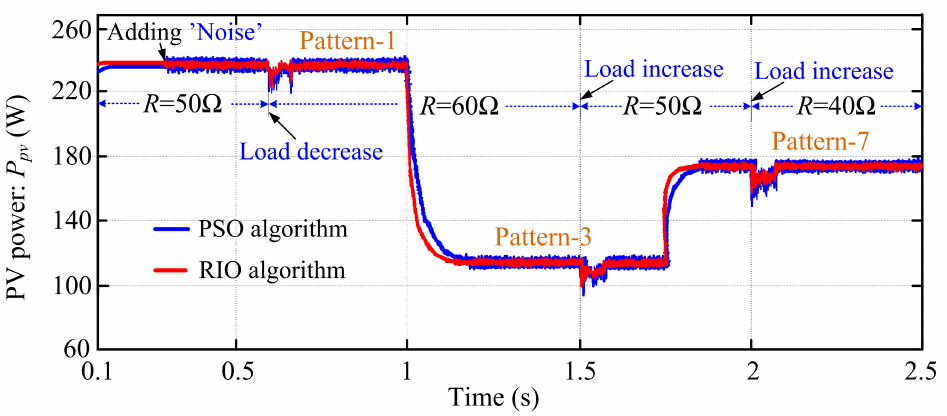
Figure 13. Comparative dynamic response of PV power ( P pv